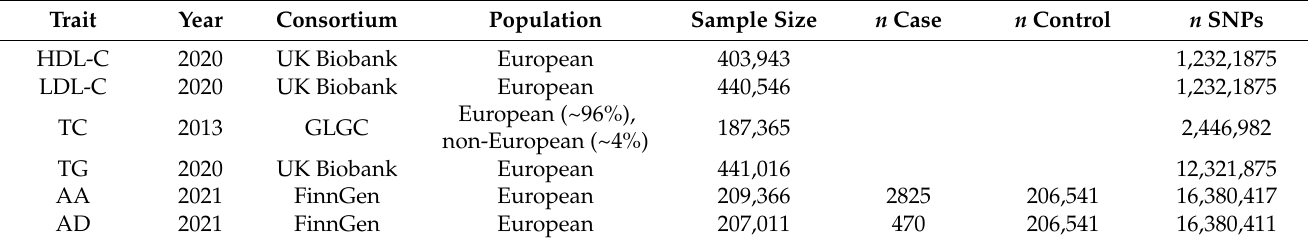
Table 1. Baseline characteristics of lipids, aortic aneurysm, and aortic dissection